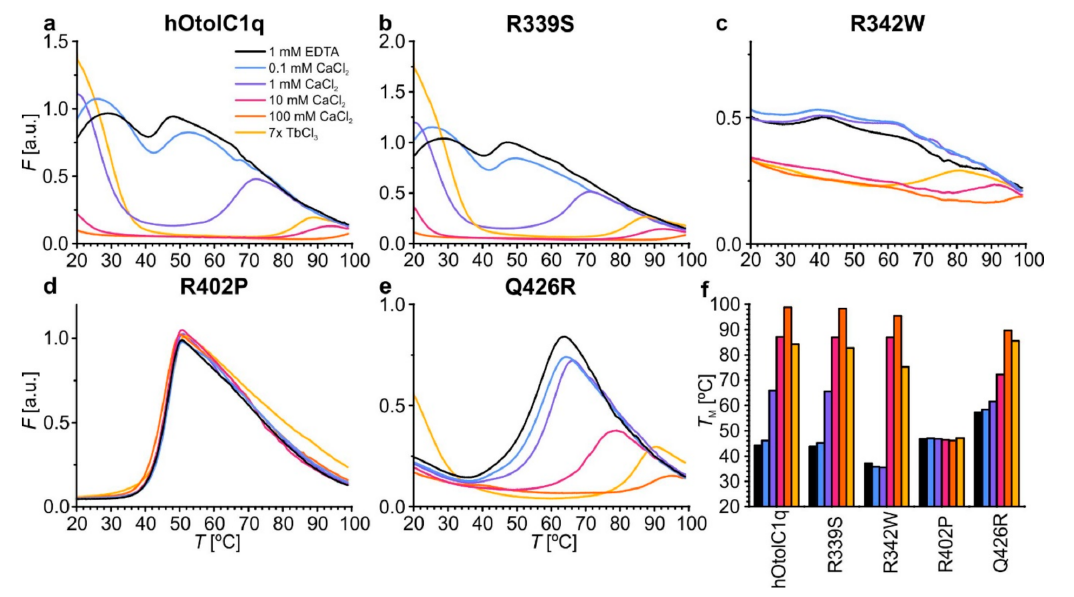
Figure 4. Changes in the thermal stability of hOtolC1q introduced by the mutations, analyzed by thermal shift assay (TSA). ( a ) Native hOtolC1q (control), ( b ) R339S, ( c ) R342W, ( d ) R402P and ( e ) Q426R. The T m values are aggregated in the bar graph ( f ) and in Table